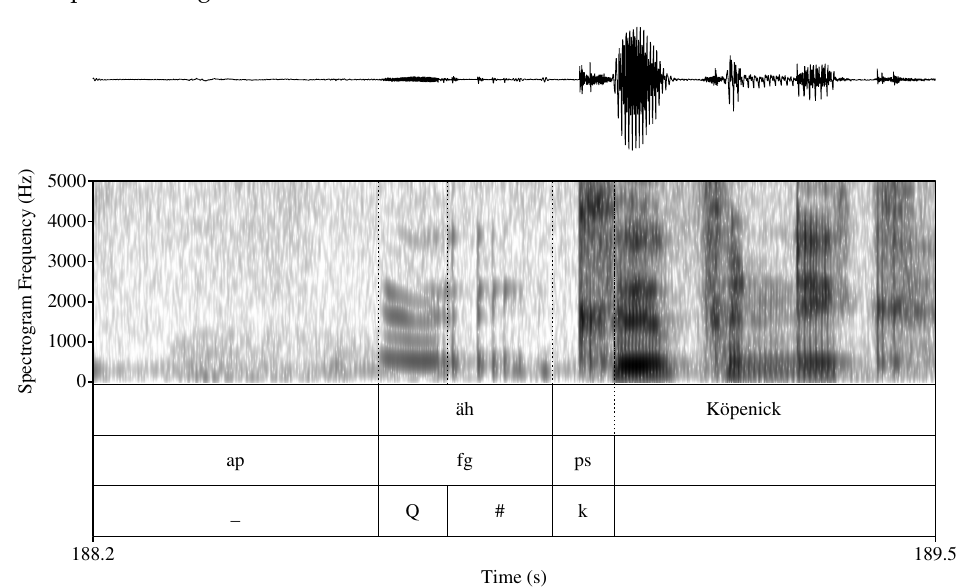
Figure 1. A filler particle (fg) consisting of a squeak (Q) and incomplete vocal fold vibration with low amplitude (#), represented graphematically with äh , preceded by a pause (ap) and followed by a segment (ps). Köpenick is a German town (source: